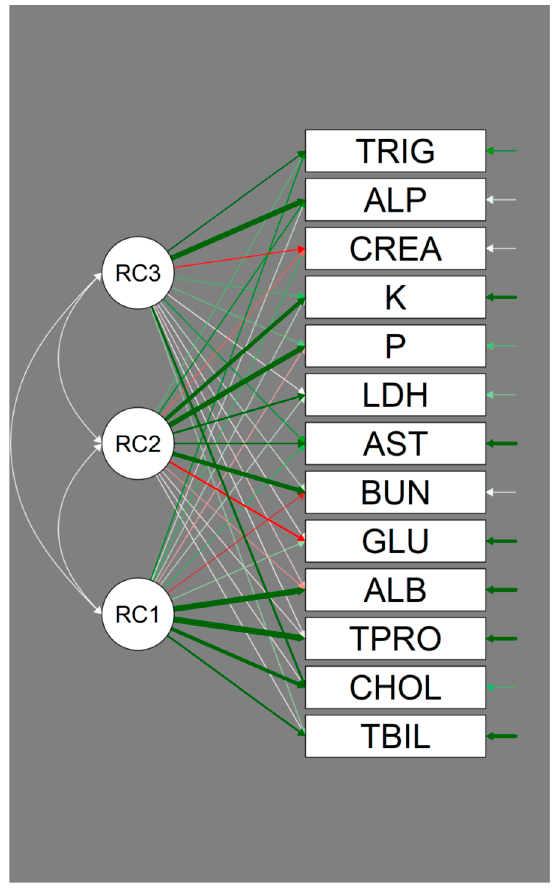
Figure 2. Path diagram. Factors are represented by circles and serum chemistry variables by boxes. The arrows going from the factors to the variables represent the loading from the factor on the variable, with green indicating a positive loading and red a negative loading. The wider the arrows, the higher the loading. Arrows below the set factor loading (0.400) are transparentized.